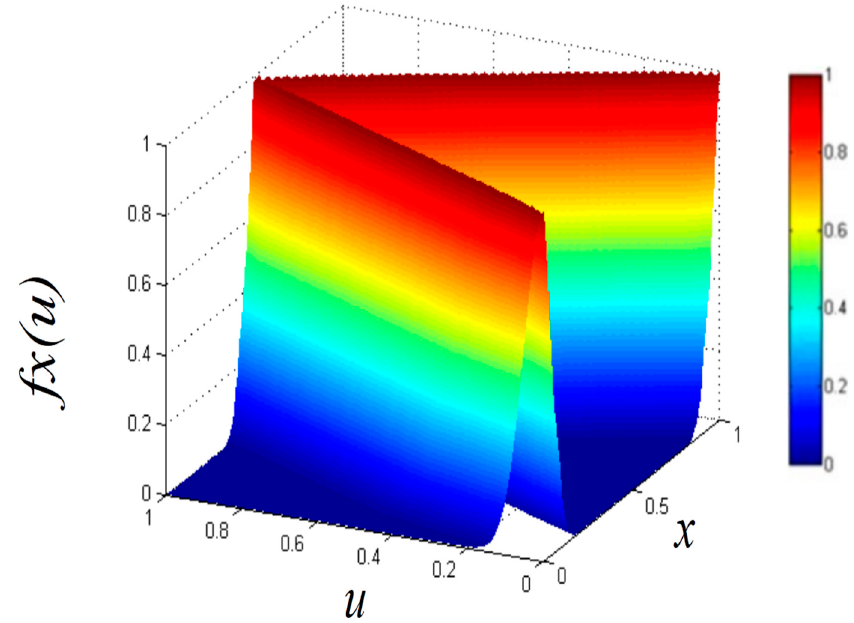
Figure 3. Visual representation of the GT2FS membership function.